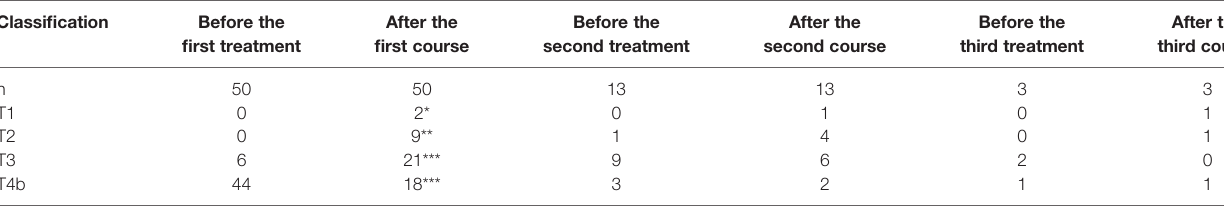
TABLE 3 | Clinical classi fi cation before and after arterial infusion chemotherapy.